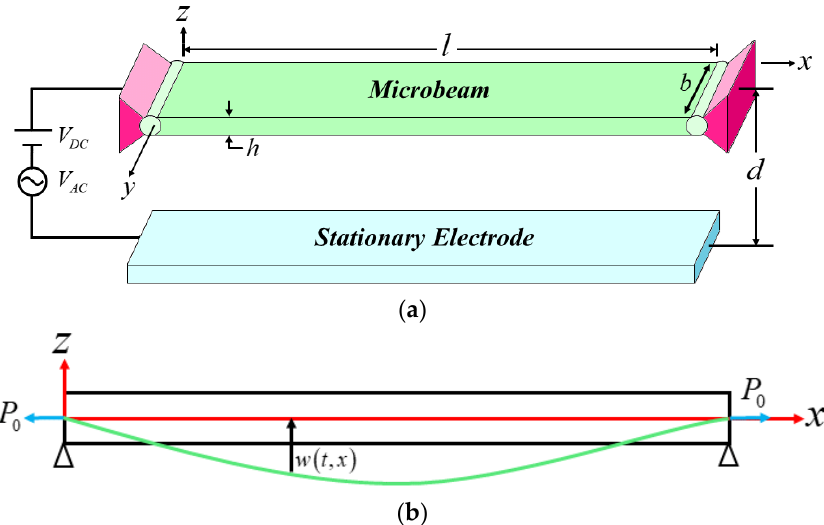
Figure 1. Microresonator model: ( a ) Schematic drawing of the resonator; ( b ) structural characteristic drawing of microbeam.